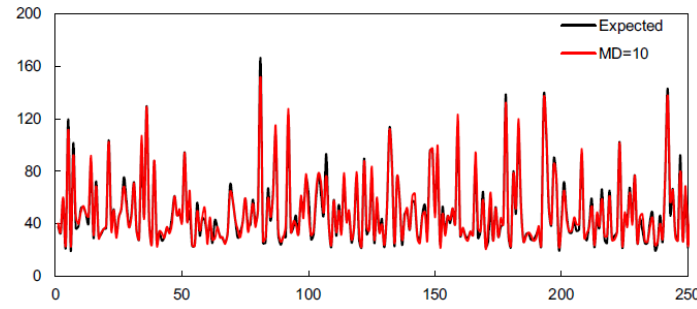
Fig. 9 Comparison of BP neural network prediction results and actual values under the colour matrix of the insulator centre